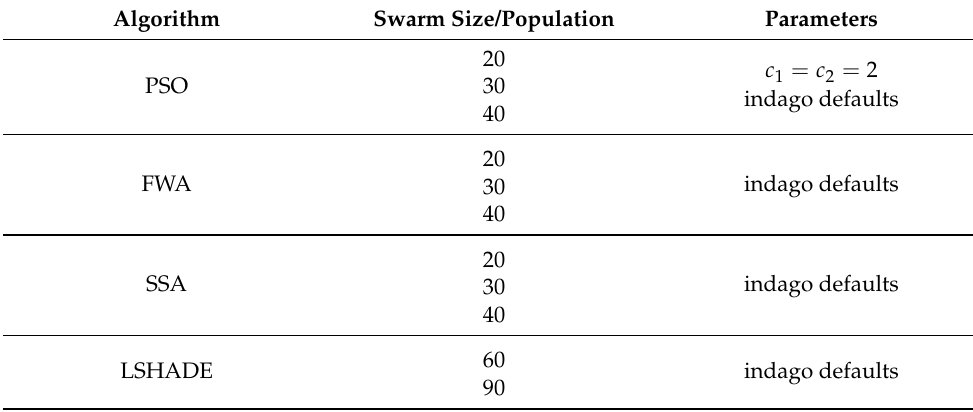
Table 6. Considered optimization algorithms and relevant